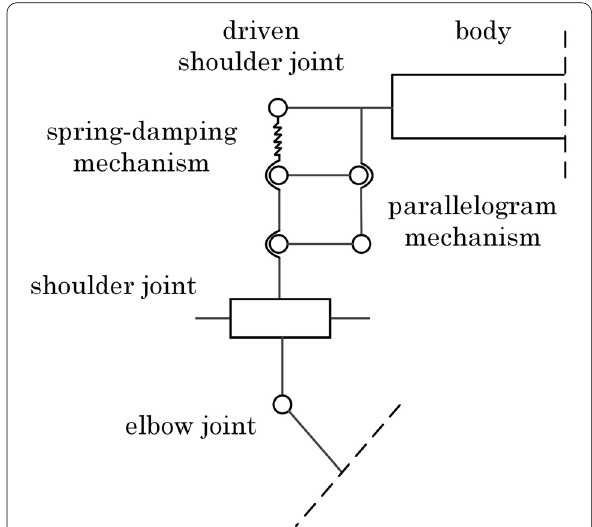
Figure 12 Improved structural sketch of the second-stage buffer system